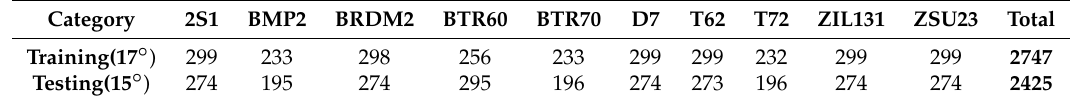
Table 2. Training and testing